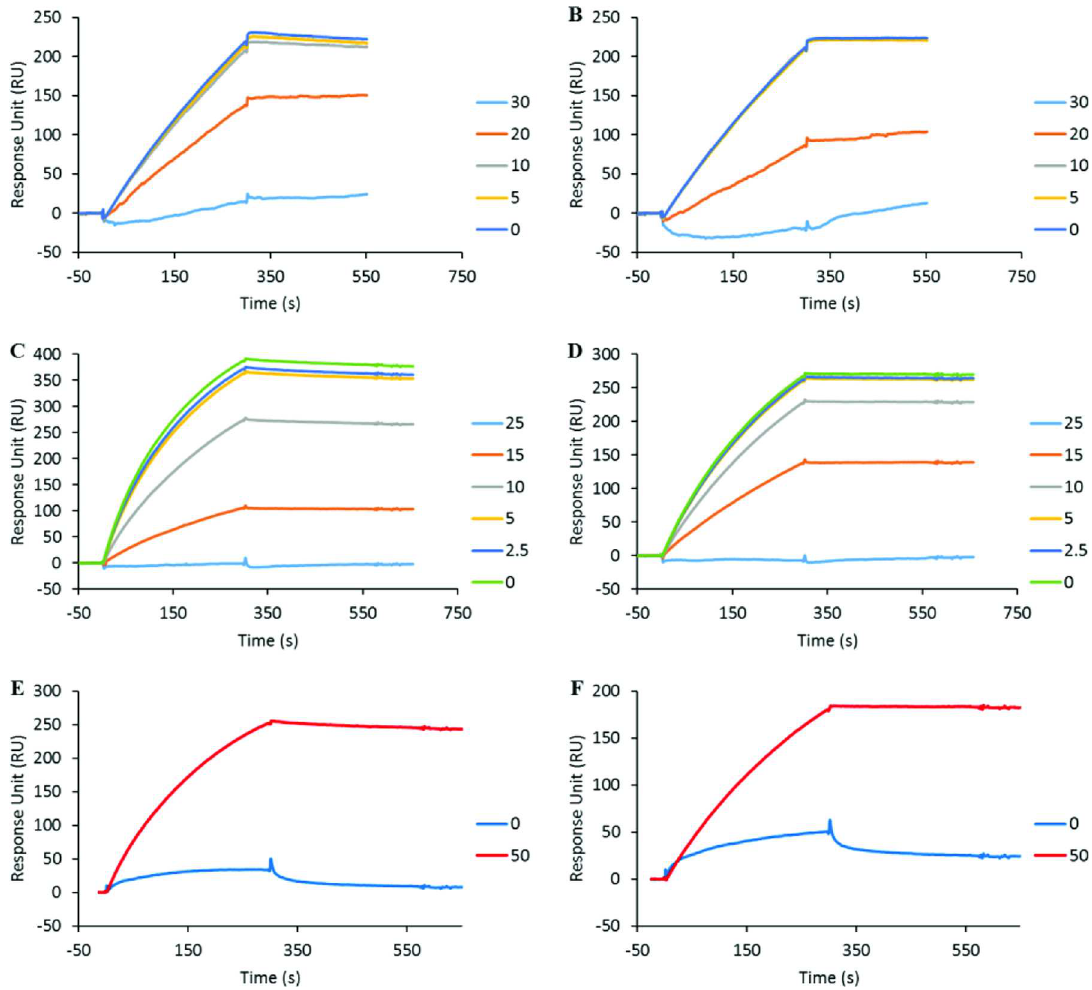
Fig 4. IND02 and IND02-trimer inhibition of gp120 binding to immobilized CD4 and mAb 17b. HIV-1 gp120 was injected over the immobilized CD4 at 10 μ l/min in the presence or absence of IND02 at the indicatedconcentrations (in μ M). The specific bindingresponsesin resonance unit (RU) for MN- (A) and YU2- (B) gp120 were recordedas a function of time (s). Similarly gp120/CD4 complex (made by pre incubating gp120 and CD4 both at 25 mM for 30 minutes at room temperature) was injected over the immobilized mAb 17b surfaces at 10 μ l/min in the presence or absence of IND02 (C,D) or IND02-trimer (E,F) at the indicatedconcentrations (in μ M). Incubations with the inhibitor lasted at least 1 hour. The specific bindingresponsesin resonance unit (RU) for MN- (C, E) and YU2- (D, F) gp120 were recorded as a function of time (s), and after each injection,the surface was regenerated by a short pulse of 10 mM